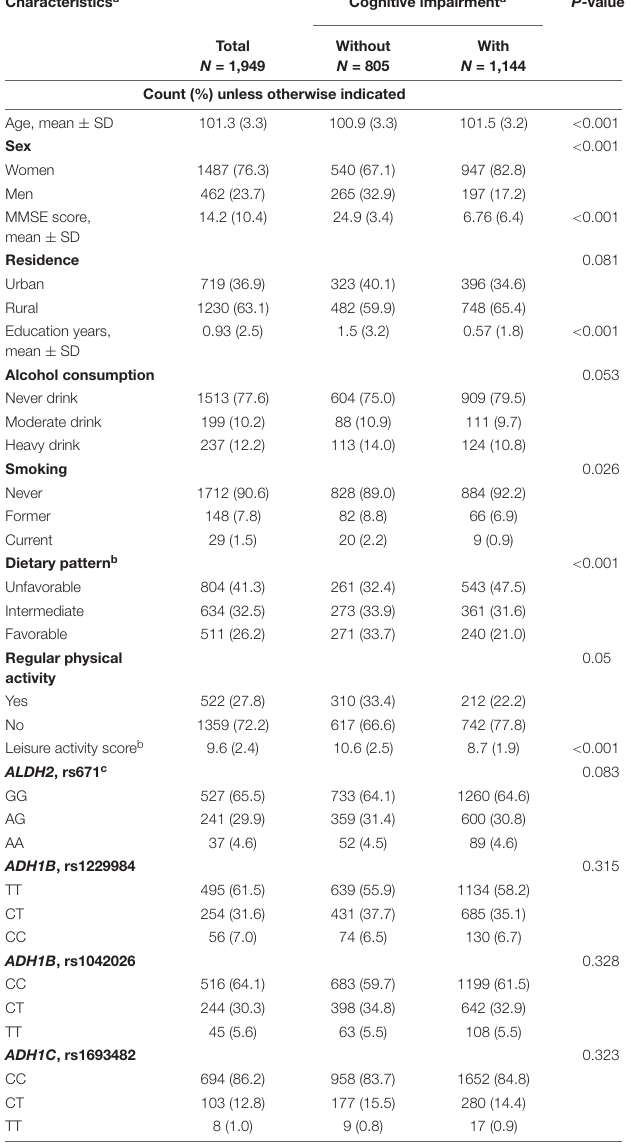
TABLE 1 | Selected characteristics of the participants by cognitive function. Characteristics a